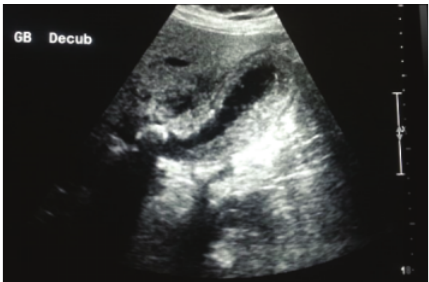
Figure 3: Gallbladder